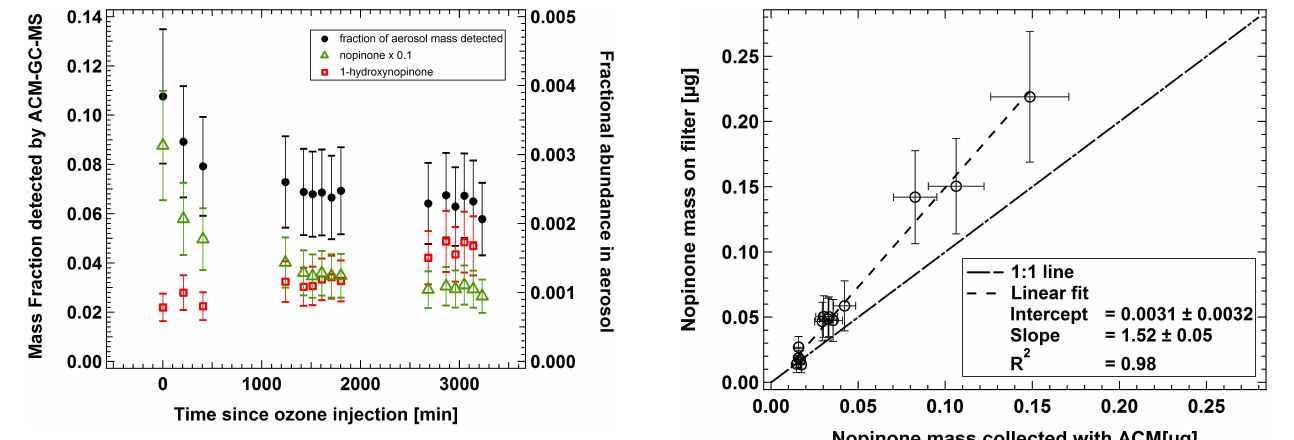
Fig. 7. Correlation between the corrected (see text) total nopinone mass sampled with filters and the total nopinone mass measured with the ACM